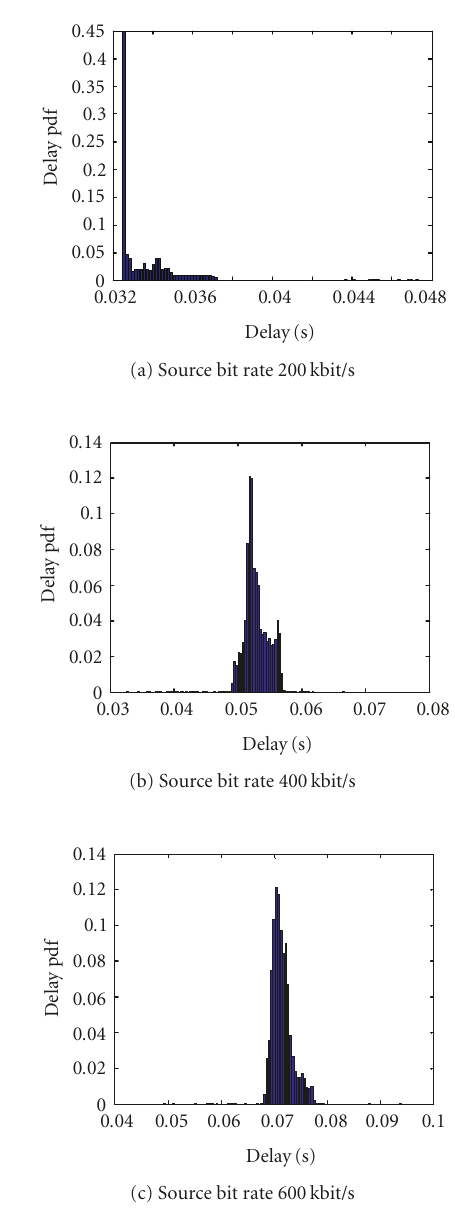
Figure 9: End-to-end delay standard deviation. Figure 10: End-to-end delay distribution for single-path routing.